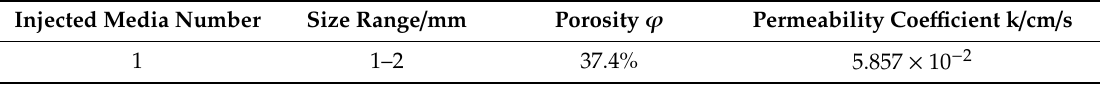
Table 1. The parameters of grouted sand.